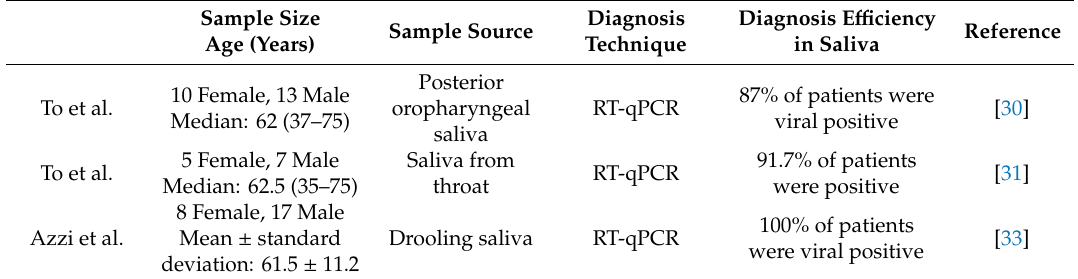
Table 1. Current clinical research finding using salivary diagnosis for